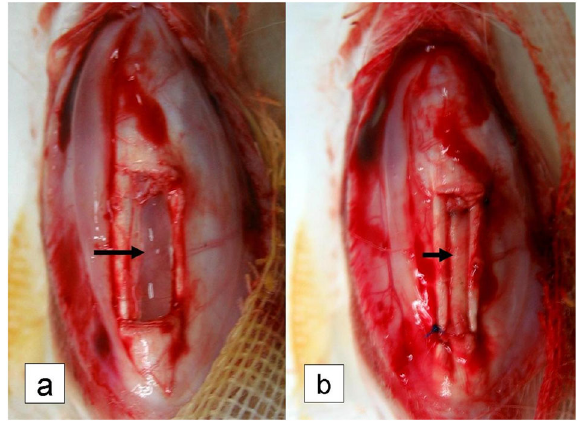
Fig. 4 Patellar tendon (PT) defect model establishment and acellular aponeurosis-discission ligament (AADL) implantation. a PT defect model (black arrow); b AADL implanted into the PT defect (black